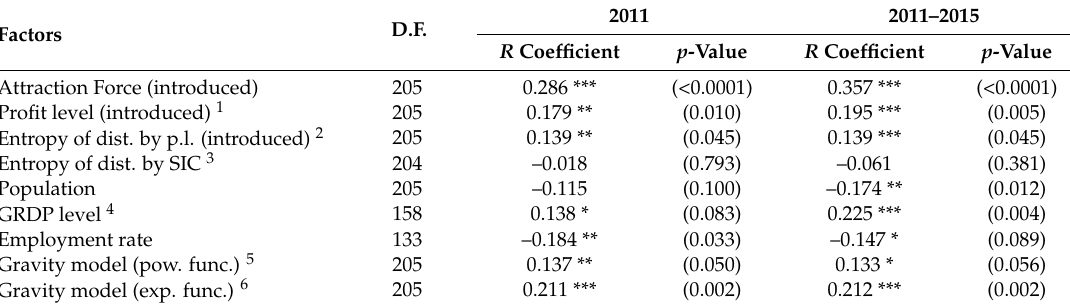
Table 1. Correlations between net migration and regional factors.